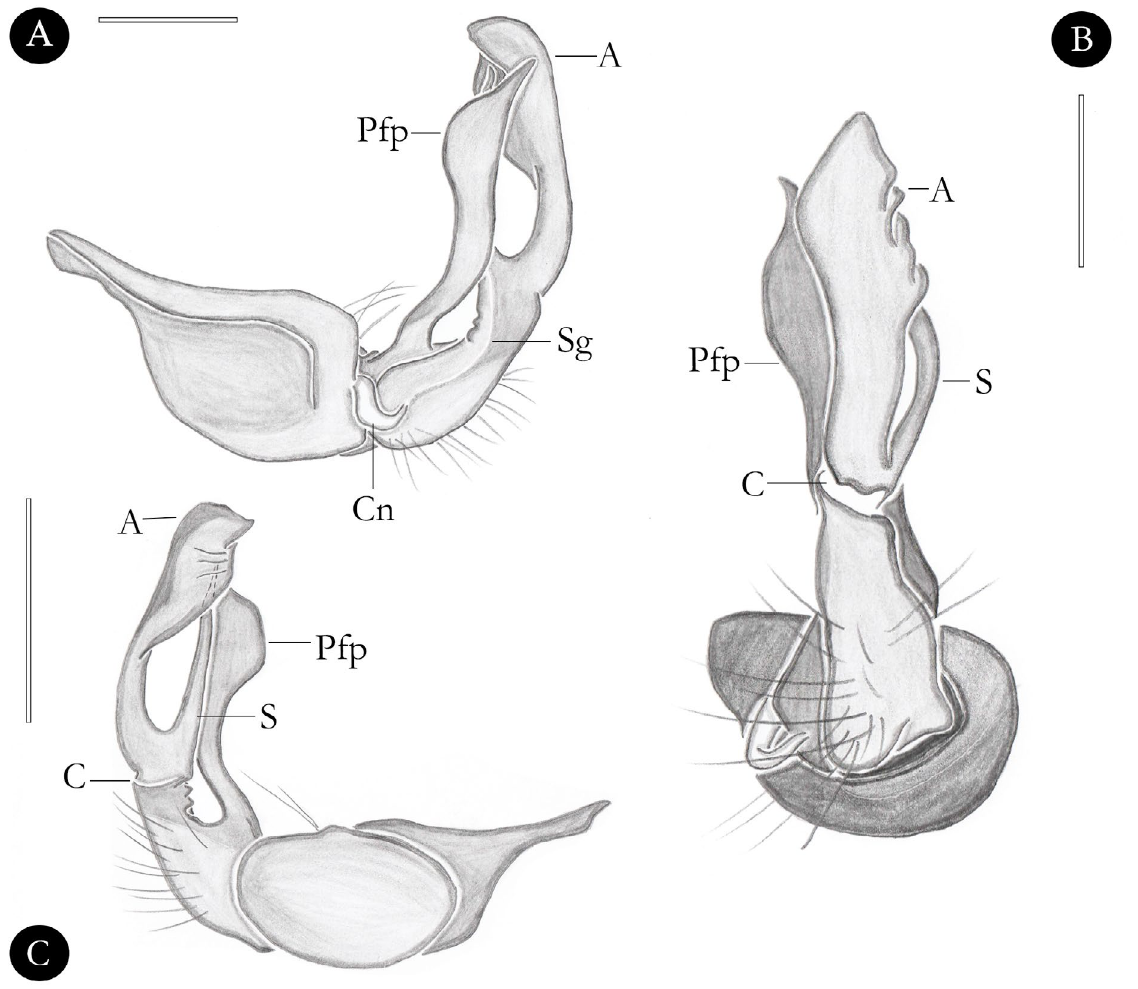
Fig. 3. Atlantodesmus sierwaldae sp. nov., holotype, ♂ (IBSP 180), schematic drawings of the gonopods. A . Mesal view. B . Ventral view. C . Ectal view. Scale bars: A–B = 250 µm; C = 500